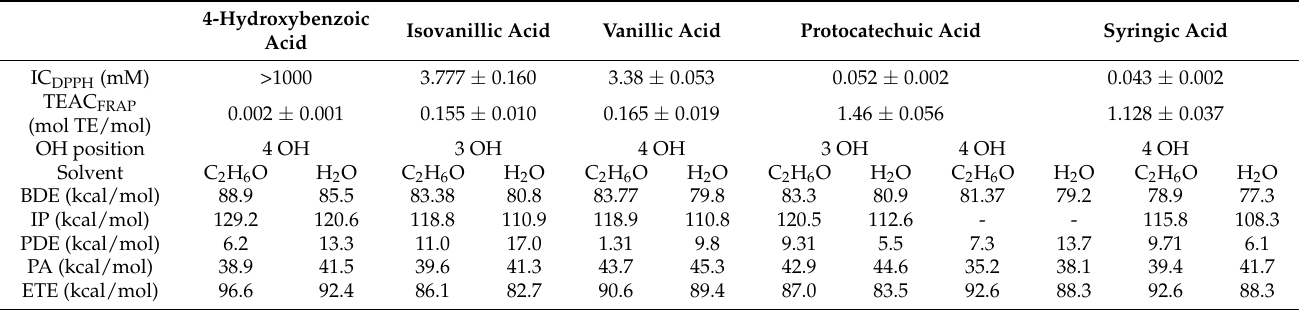
Table 2. IC 50 and TEAC FRAP values for phenolic acids with the calculated thermodynamic parameters: bond dissociation enthalpy (BDE), ionization potential (IP), proton dissociation enthalpy (PDE), proton affinity (PA), electron transfer enthalpy (ETE). Based on